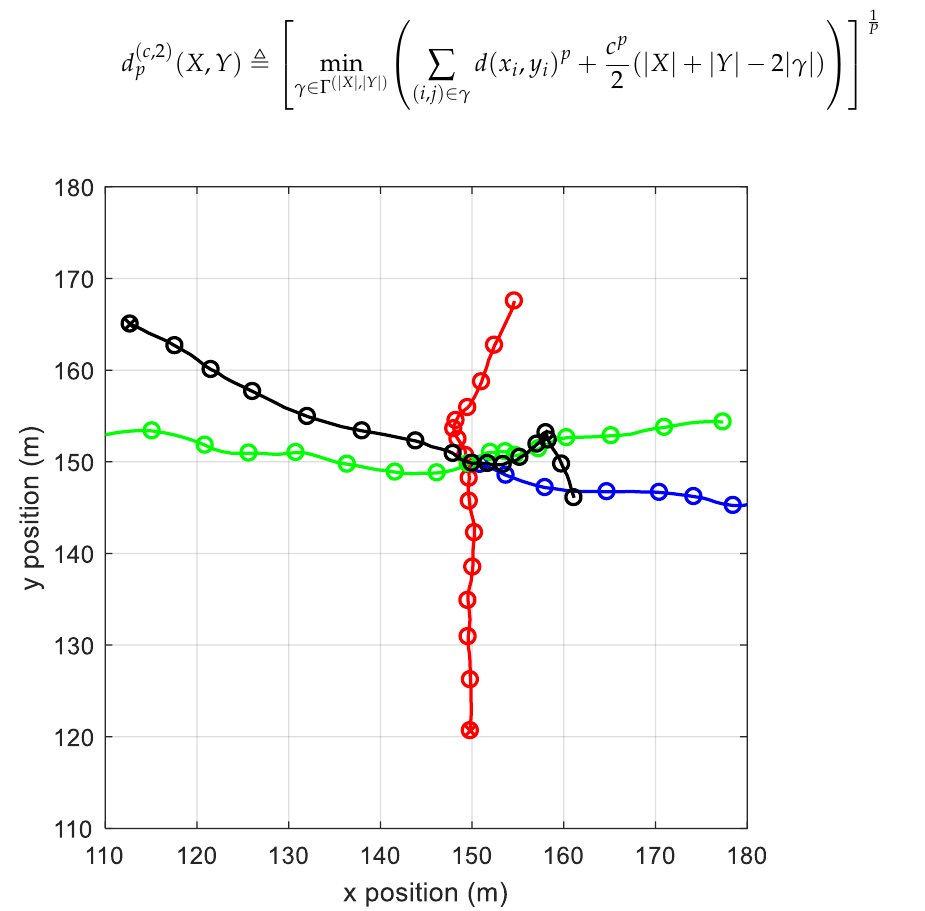
Figure 1. Multi-target scenario. There are four targets, all born at Step1. The blue target dies at Step 40 and the others are alive the entire time.